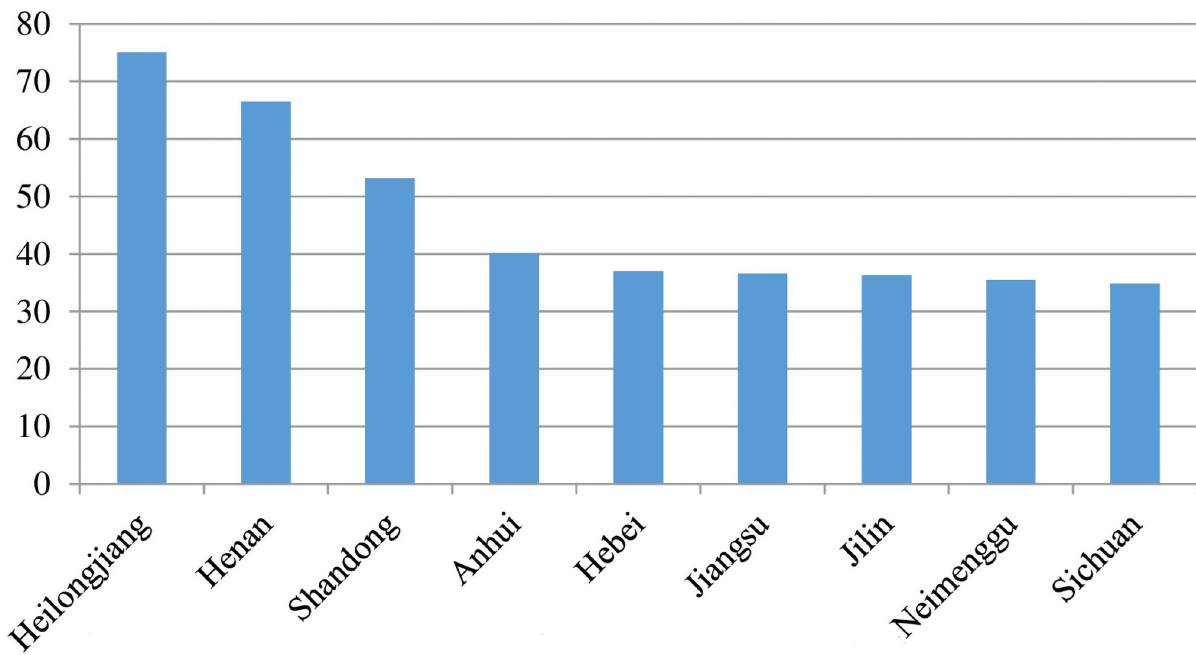
Fig 2. Gross grain output of China’s provinces (top 9) in 2007. Unit: Million tons. Data source: China’s National Bureau of Statistics (CNBS) 2007.